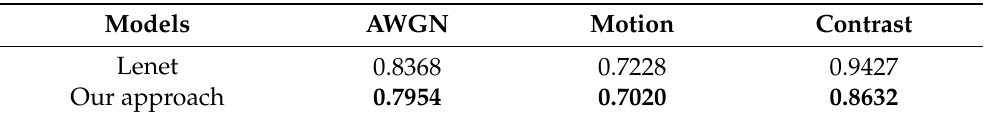
Table 6. Performance (inference time in ms) comparison between the Lenet architecture (with FC layers) and our hybrid Lenet–Hopfield architecture.